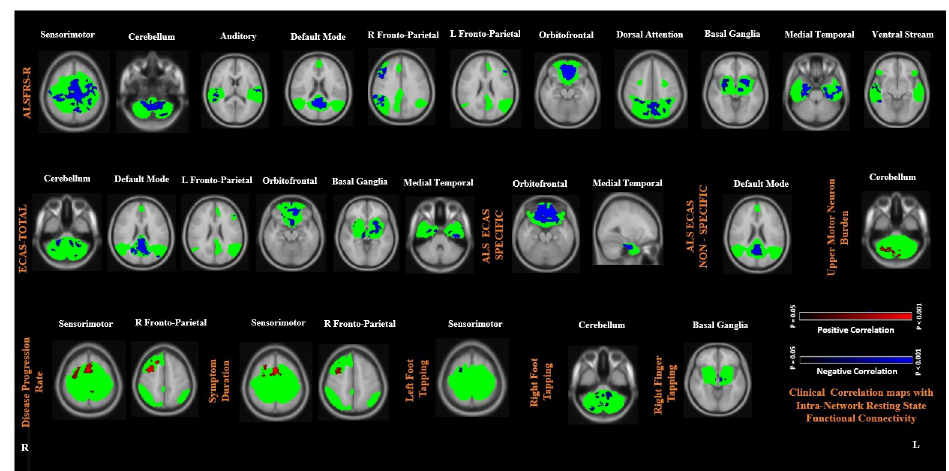
Fig 3. Significant correlations between higher intra-network resting-state functional connectivity (Rs-FC) and the clinical variables of Amyotrophic lateral sclerosis (ALS) patients. ALS functional rating scale revised (ALSFRS-R); Edinburg Cognitive and Behavioral ALS screening (ECAS) Total score and Specific and Non-Specific subdomain scores; Upper motor neuron (UMN) burden; Disease Progression Rate; Symptom duration; Left and Right foot tapping; and Right finger tapping. Red: Positive correlation. Blue: Negative correlation. Green: Mask obtained from the respective RSNs. Results were corrected for the multiple comparisons using the family-wise error approach at p < 0.05. Color bar represents 1-p values. Brain maps are shown in radiological